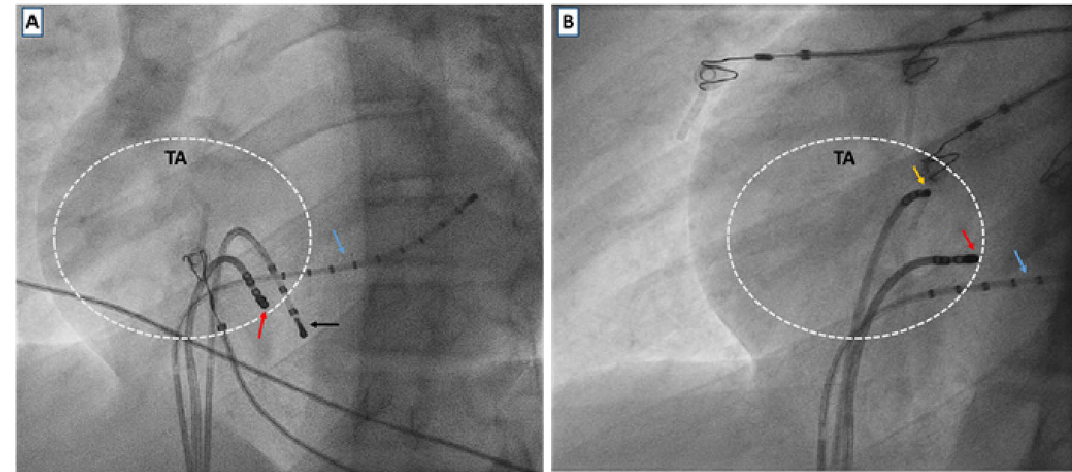
Fig. 3 A: Left anterior oblique fluoroscopic image showing a successful ablation site (red arrow) in twin A. A decapolar catheter is placed in the coronary sinus (blue arrow). A quadripolar catheter in the right ventricle is shown in black. B: Left anterior oblique fluoroscopic image showing a successful ablation site (red arrow) in twin B. A quadripolar catheter is located at the His-bundle (orange arrow). A decapolar catheter in the coronary sinus is shown in blue. Dashed circle represents the approximate location of the tricuspid annulus.